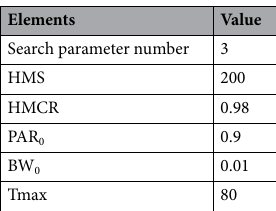
Table 4. Initialization parameters of DFPID-HAS.